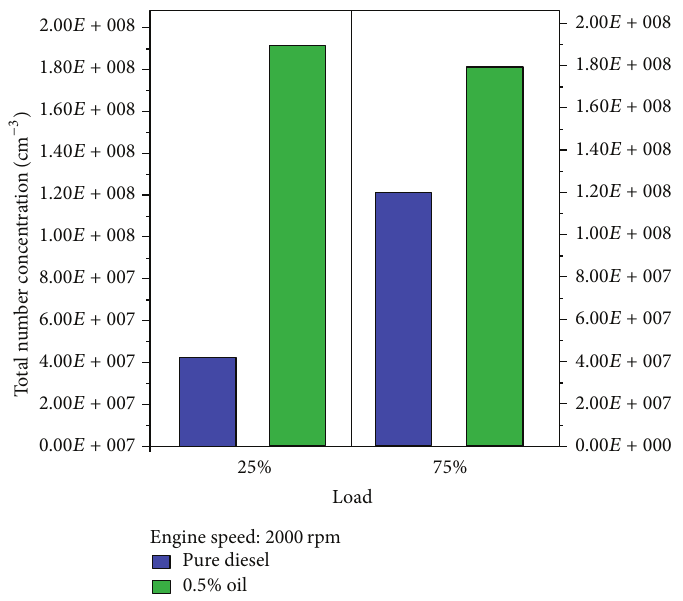
Figure 7: Total number concentrations under different